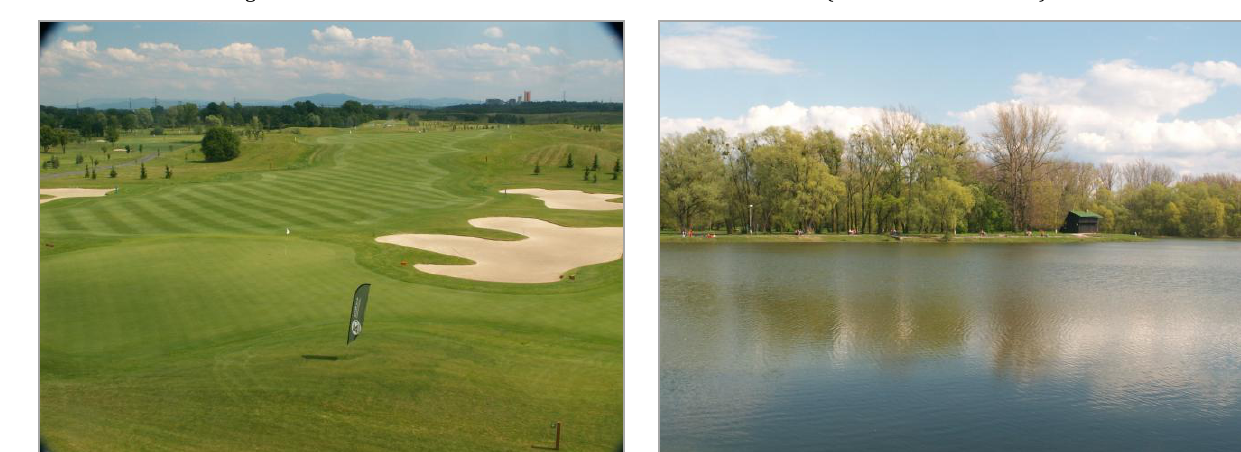
Fig. 4. The devastated and reclaimed area of Karviná – Darkov (www.kontaminace.cz)